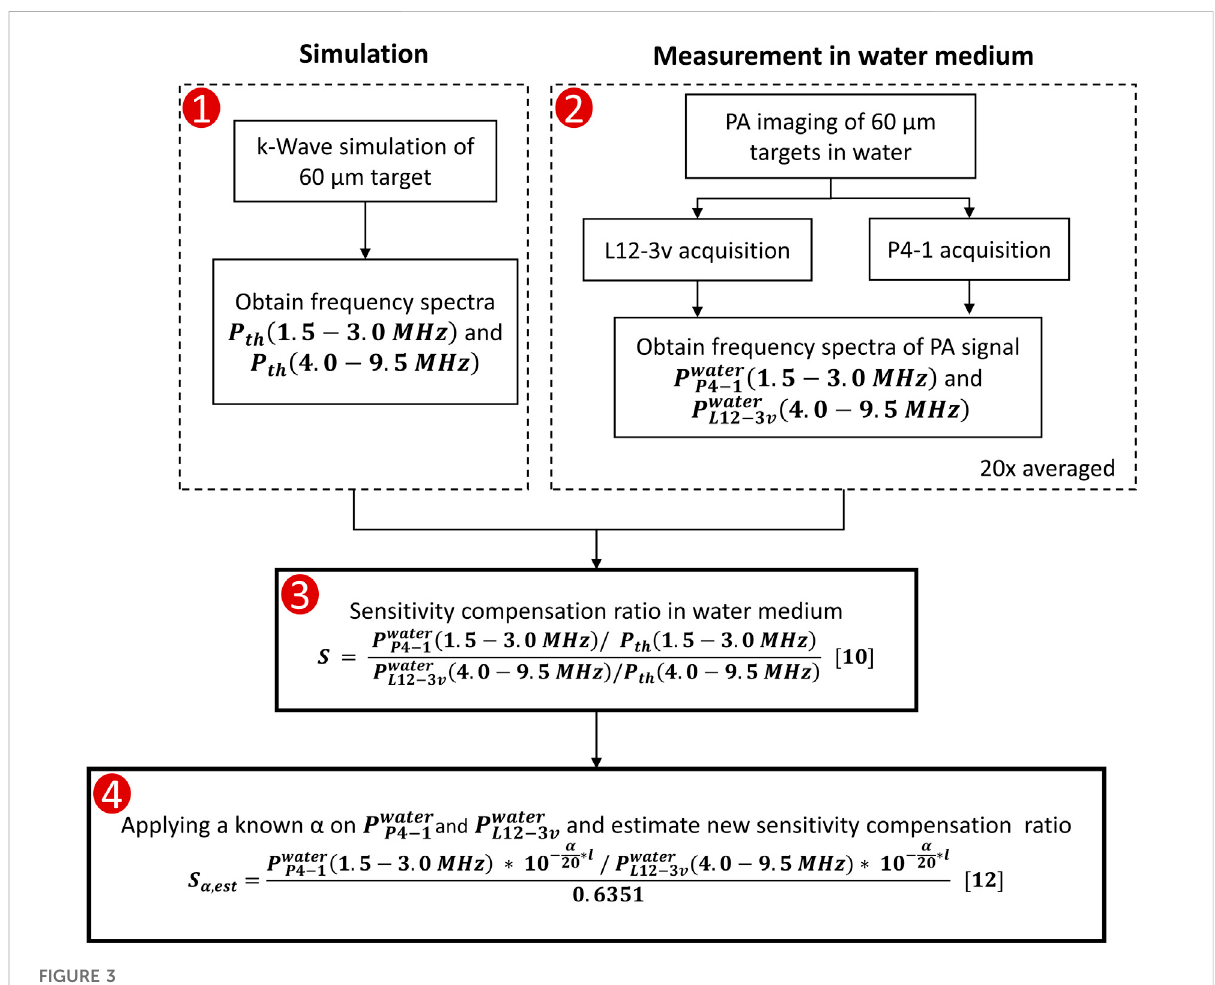
FIGURE 3 Flowchart describing the methodology used to fi nd the sensitivity compensation ratio S and S α , est . Steps 1 and 2: Calculation of spectral amplitudes for a 60 μ m target from simulation and experiment. Steps 3 and 4: Calculation of the sensitivity compensation ratio in water medium ( S ) and the ratio that includes the effect of acoustic attenuation ( S α , est